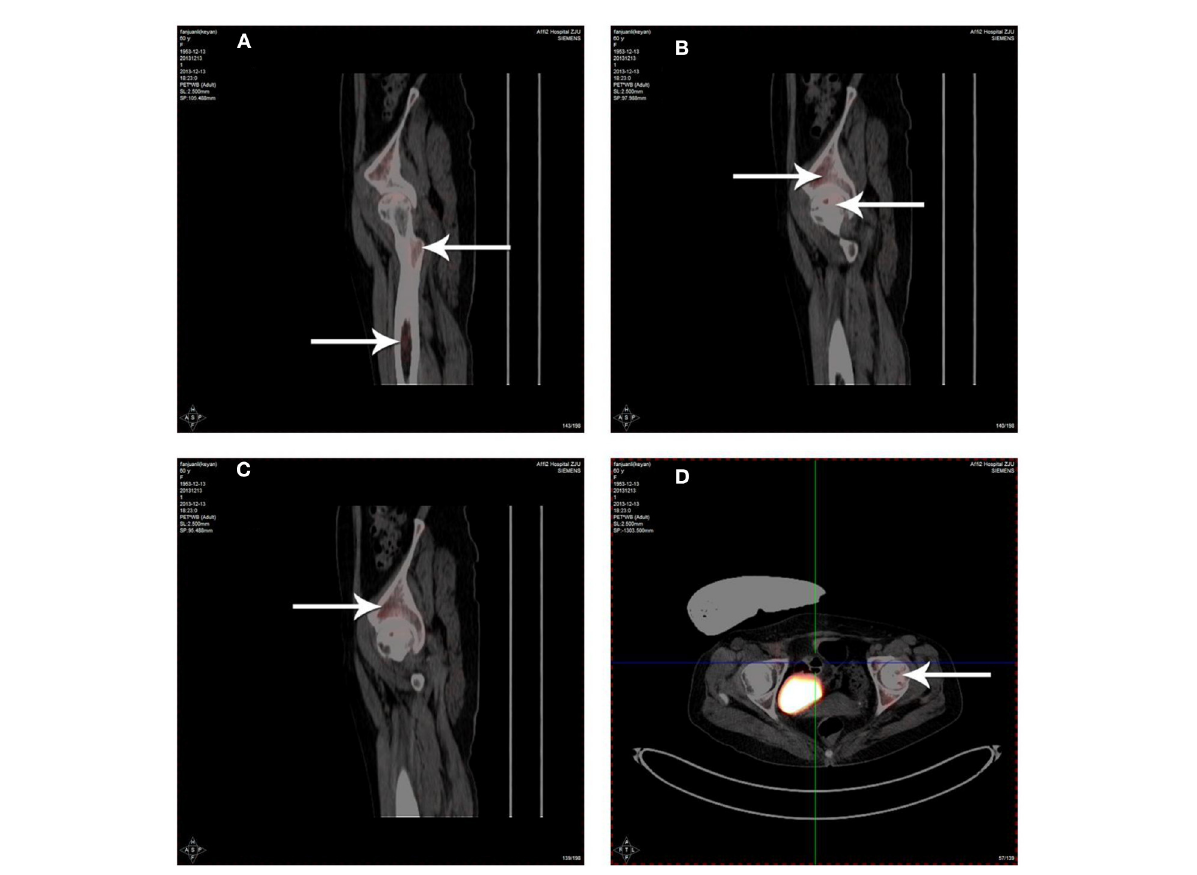
FIGURE3 Distribution of 18 F-FDG labeled PBSCs after infusion via the medial circumflex femoral artery. The 18 F-FDG labeled PBSCs could be observed in the femoral bone marrow cavity (A) , necrotic area of the femoral head (B,D) and acetabulum (C) . The 18 F-FDG labeled PBSCs could be seen in necrotic area of the femoral head indicating that PBSCs could enter into the femoral head and migrate into necrotic field of the femoral head participating in the repair of osteonecrosis after infusion through the medial circumflex femoral artery.